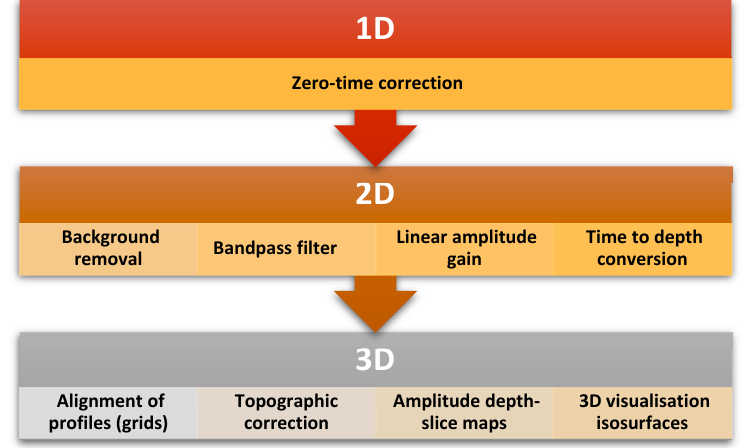
Figure 9. Flowchart of the main processing steps applied to raw reflection data collected by GPR in this study.